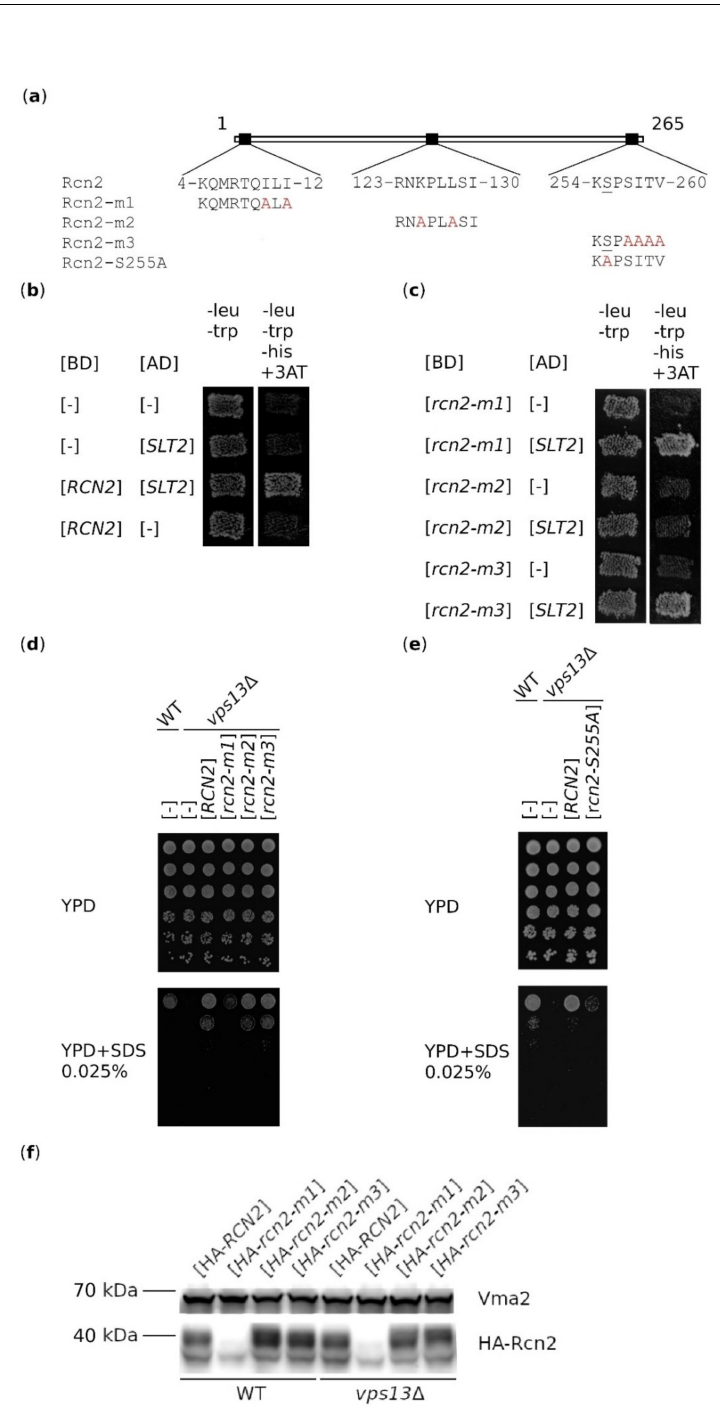
Figure 2. Rcn2-binding to Slt2 is not important for suppression of vps13 ∆ SDS hypersensitivity, in contrast to serine residue S255 and the motif at the N-terminus of Rcn2. ( a ) Schematic representation of Rcn2 indicating three potential Slt2-binding sites. Amino acid residues substituted in mutant proteins, Rcn2-m1, Rcn2-m2, Rcn2-m3, and Rcn2-S255A, are in red. S255 is underlined. ( b ) Rcn2 and Slt2 interact in the two-hybrid system. ( c ) Rcn2-m2 does not interact with Slt2. BD, DNA-binding domain; AD, activating domain; 3AT, 3-aminotriazole. rcn2-m1 ( d ) and rcn2-S255A ( e ) are not able to suppress the hypersensitivity of vps13 ∆ to SDS. Serial dilution of wild-type and vps13 ∆ strains transformed with empty vector [-] or vector bearing the RCN2 gene were plated on YPD and YPD + SDS. Plates were incubated for 3 days. ( f ) rcn2-m1 is less efficiently expressed. Western blot analysis of HA-Rcn2 and HA-Rcn2-m1, -m2 and -m3 levels in wild-type and vps13 ∆ mutant cells. The tagged versions of Rcn2 were detected with the anti-HA antibody. The levels of vacuolar protein Vma2 were used as a loading